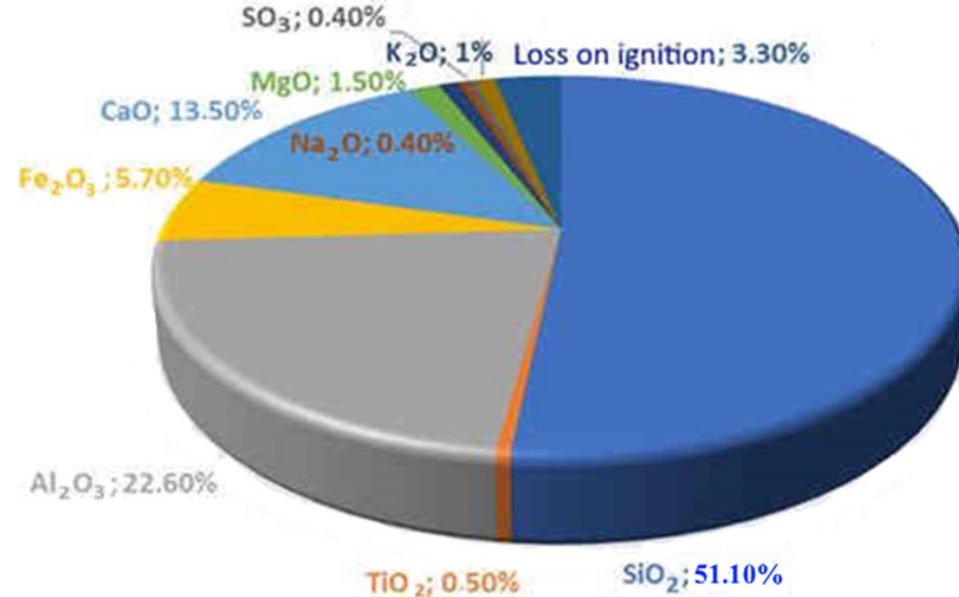
Figure 3. Chemical composition of the original coal ash.